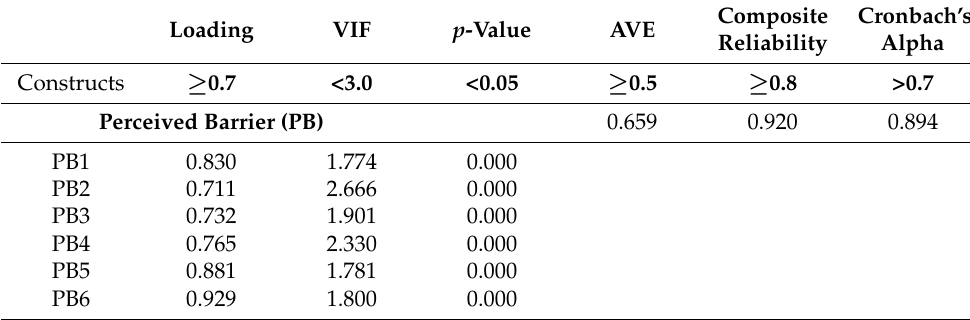
Table 10. Construct validity and reliability for Hypothesis